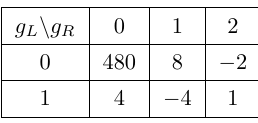
) = (1 , 0 , 1) in E , d 2 , d 3